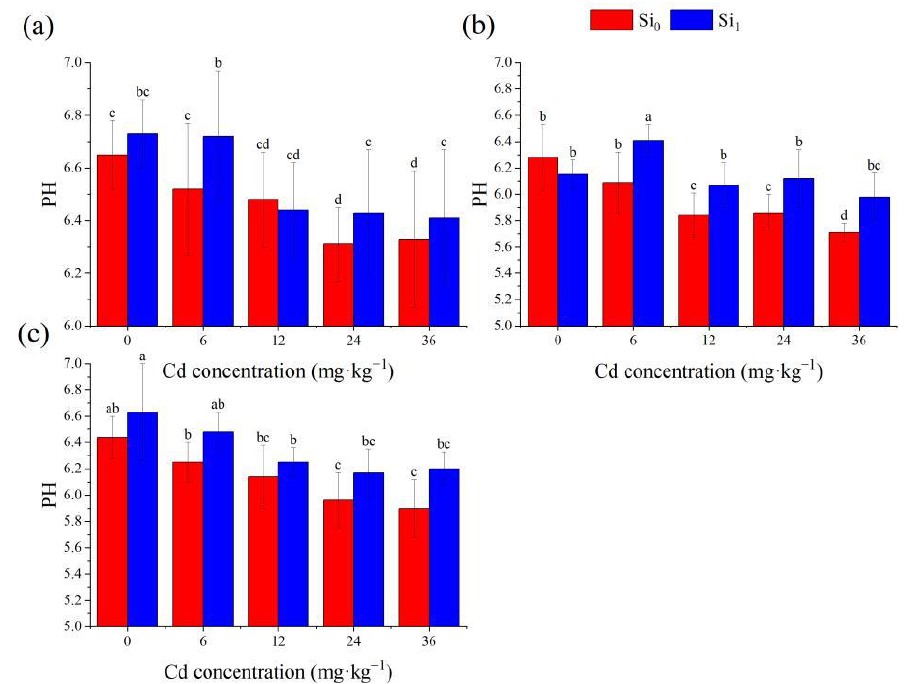
Figure 5. Effects of Cd and Si on soil pH of seedlings for ( a ) Schima superba , ( b ) Chinese sweetgum, and ( c ) Chinese fir. Lowercase letters above the bars indicate significant differences according to the Turkey’s test. ( p < 0.05).